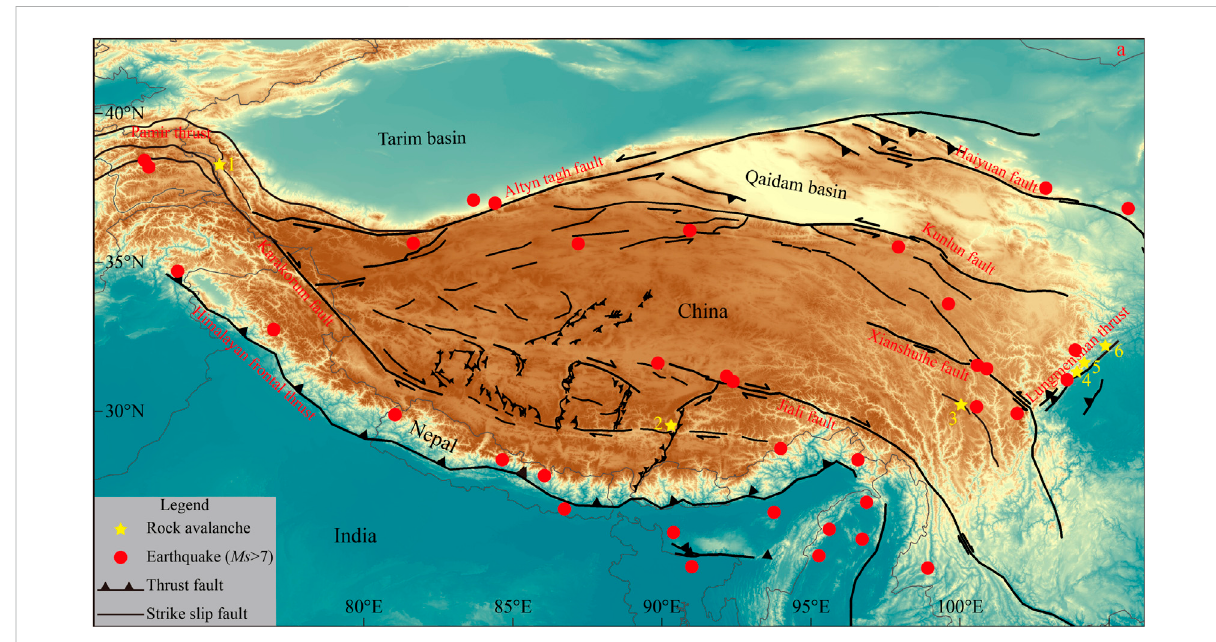
FIGURE 1 Geological map of the Tibetan plateau with the locations of the studied rock avalanches marked.